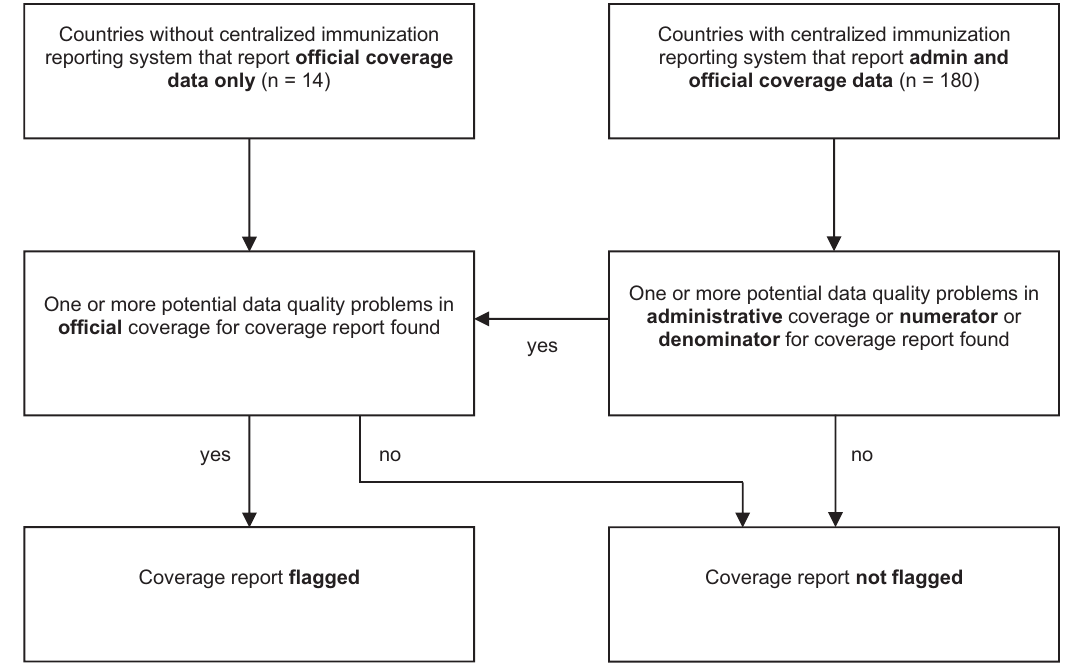
Fig 1. Method for flagging the quality of reported immunization data by type of country immunization reporting system for 194 WHO Member States. Notes: Countries without a centralized immunization reporting system were: Andorra, Austria, Belgium, Canada, Finland, France, Germany, Greece, Luxemburg, Monaco, Norway, Sweden, Switzerland, and the United States of America. For detailed flowcharts listing all data quality checks for each vaccine dose by type of country immunization reporting system see S1-S4 Figs in S1